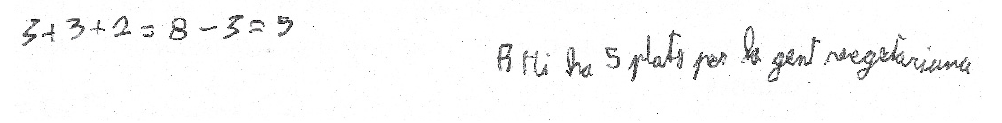
Figure 9. Incorrect answer of Q4. Arithmetical strategy. CC1 cognitive conflict (translation: there are 5 dishes for vegetarians).